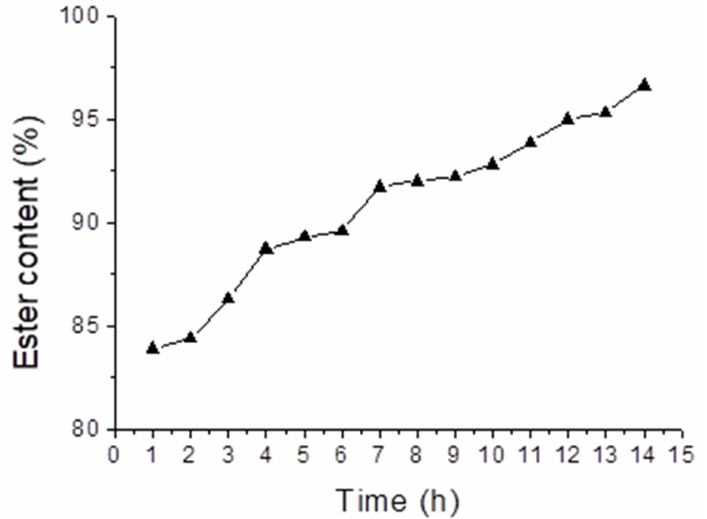
Figure 2. Effect the time on esterification of acid oil. Reaction conditions: Molar ratio of methanol/acid oil 18:1; 4% of H 2 SO 4